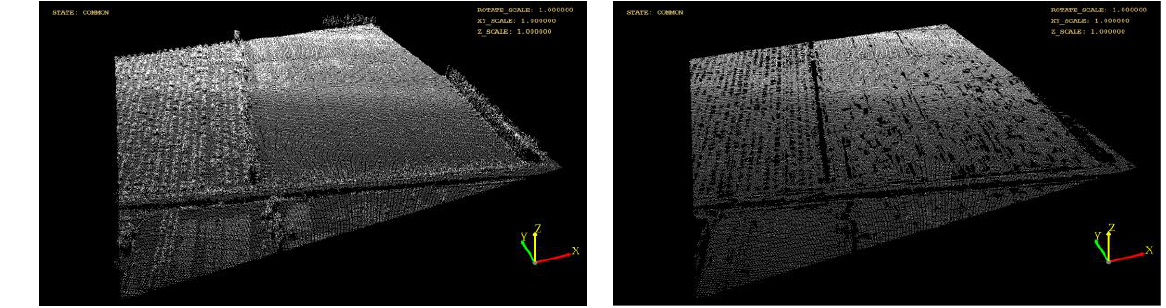
Figure 4. Filtering result of crop land